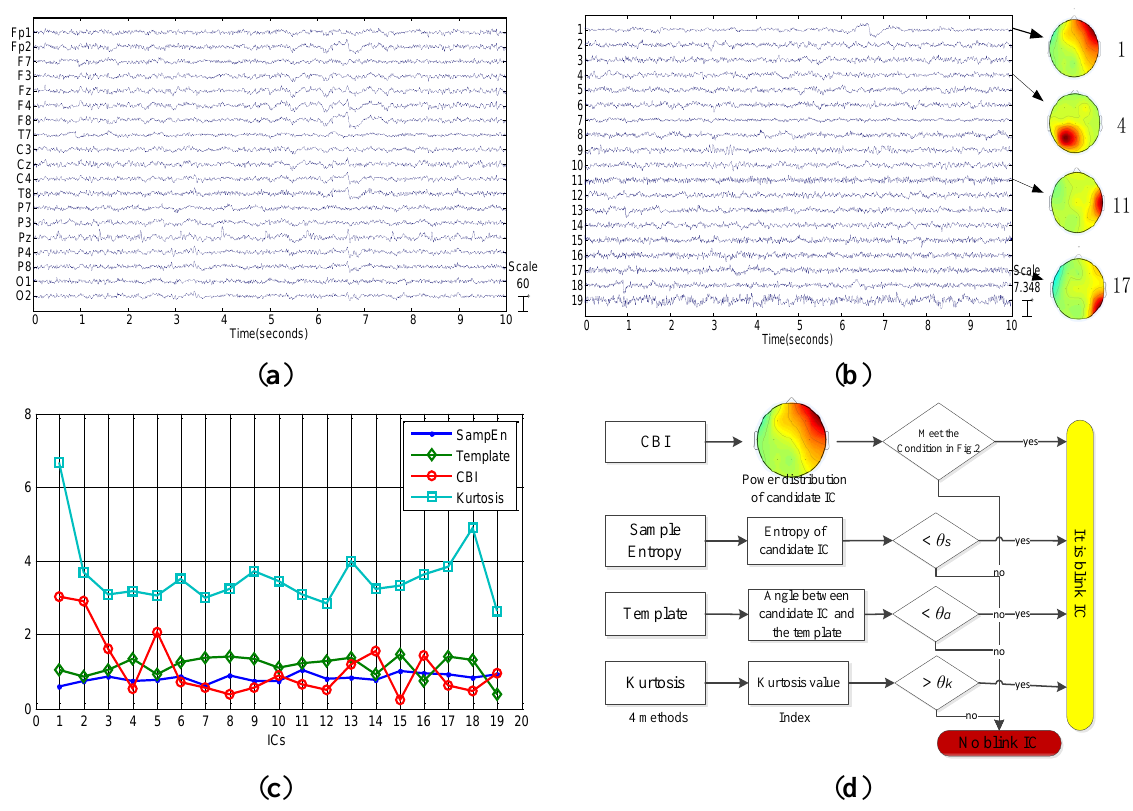
Figure 7. No-blinks case. ( a ) Original signals; ( b ) Independent components decomposed by Extended Infomax ICA and scalp topographies corresponding to weights of some components; ( c ) Values of CBI, sample entropy, kurtosis and template angle corresponding to all components; ( d ) Procedures of judging blink IC for 4